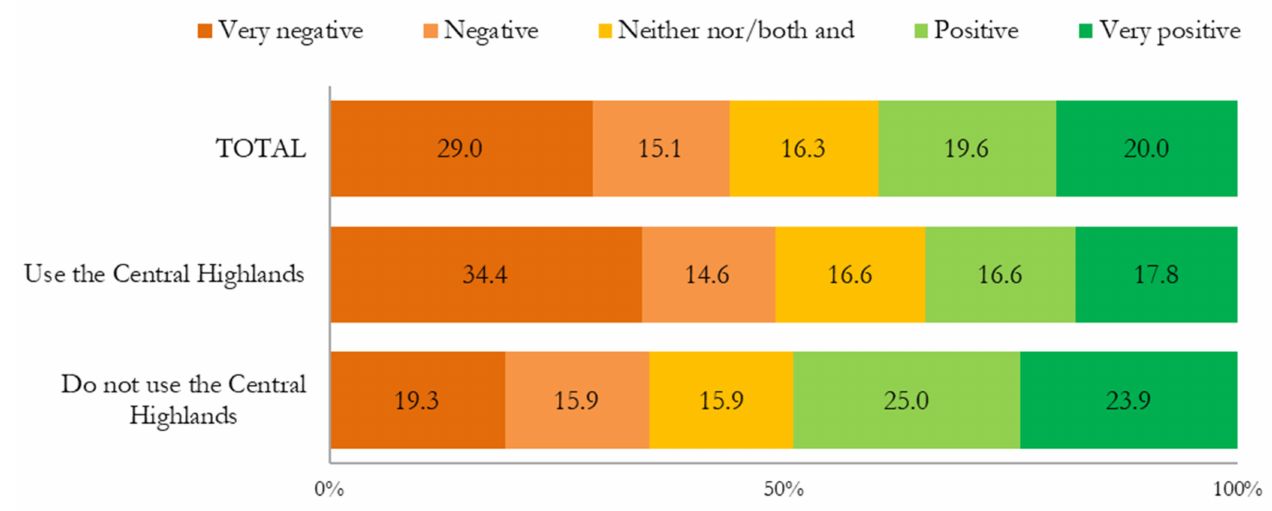
Figure 5. Tourism industry attitudes towards the proposed Central Highlands National Park. Table 2. Analysis of the attitudes towards the proposal of a Central Highlands National Park based on whether the tourism companies use the Central Highlands (CH) for their operations or not. N Avg. SD t -Test Do not use the Central Highlands 88 Use the Central